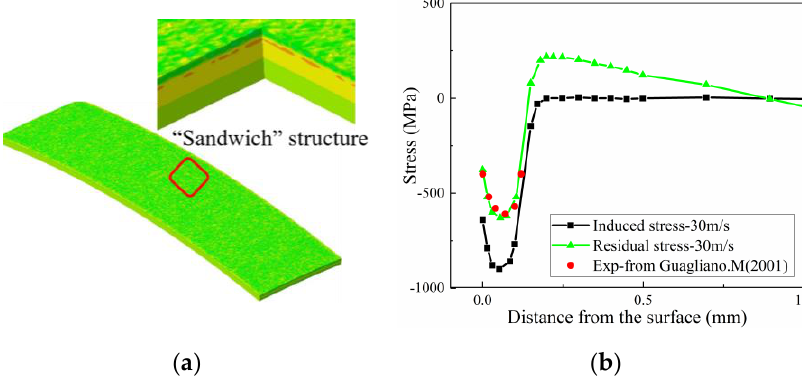
Figure 17. Removal constraints for the Almen strip. ( a ) “Sandwich” structure. ( b ) Comparison of the induced stress, residual stress from this paper and residual stress from Guagliano [16].